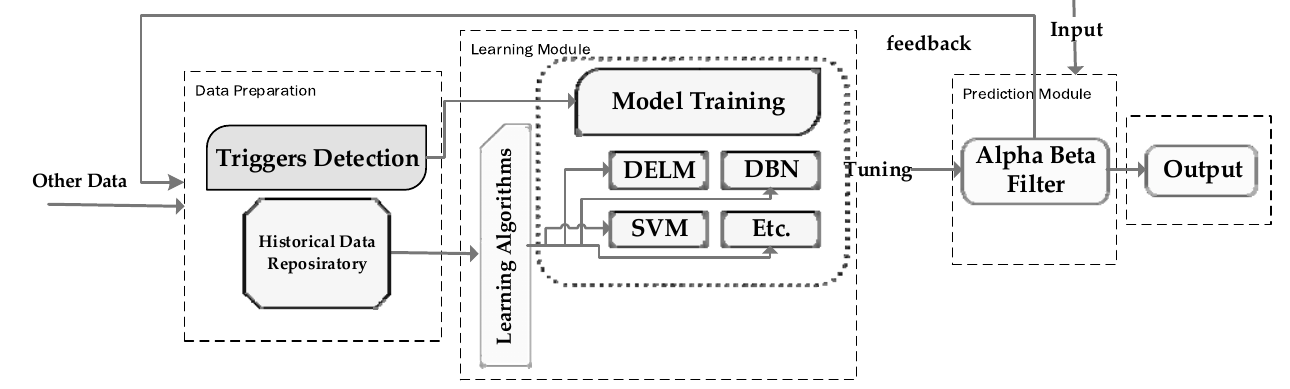
Figure 1. The conceptual model of the proposed learning algorithm for the alpha-beta filter model.